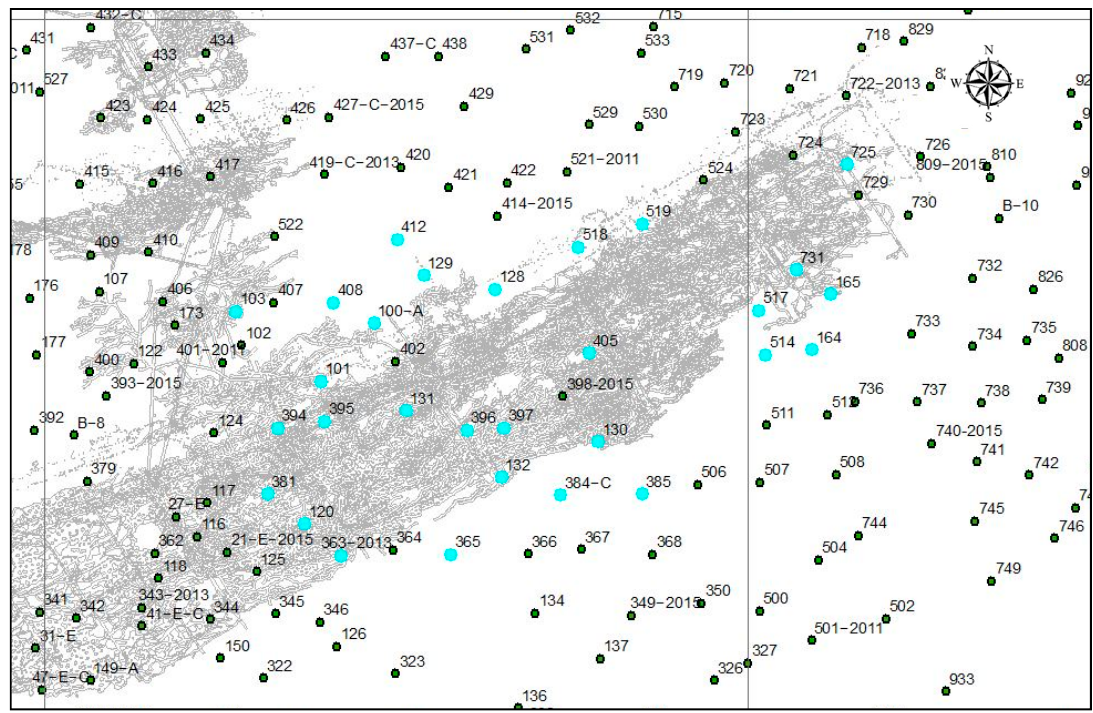
Figure 9. Control points that meet the pre-established conditions. Scale 1:12,500.